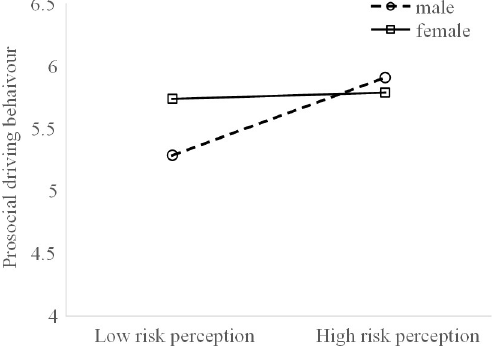
Fig 5. Simple slope analysis of prosocial behaviours-gender × risk